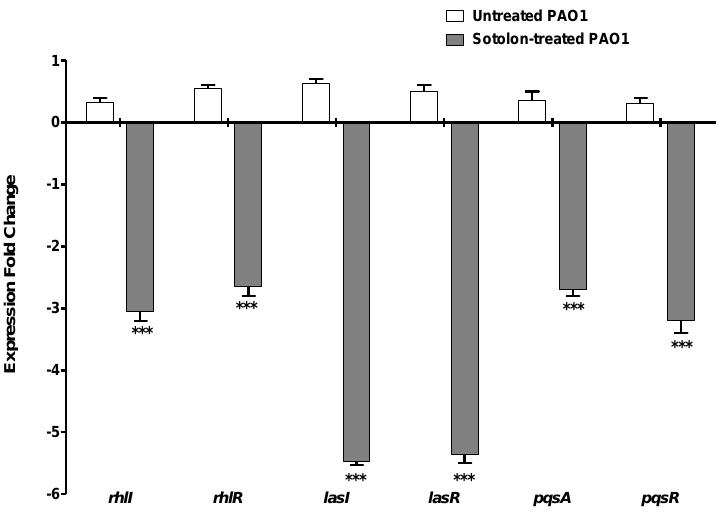
Figure 3. Sotolon downregulated P. aeruginosa QS genes. RNA was isolated from PAO1 cultures treated and untreated with sotolon in sub-MIC (50 µg/mL) and was quantified by qRT-PCR and changes in the expression of each QS gene were normalized in relation to the mean critical threshold values of housekeeping gene rpoD. The data shown are the mean ± standard errors from three experiments. p < 0.05 was considered significant using one-way ANOVA test. Sotolon significantly reduced the expression of all tested genes ( p < 0.0001). *** = p < 0.001.